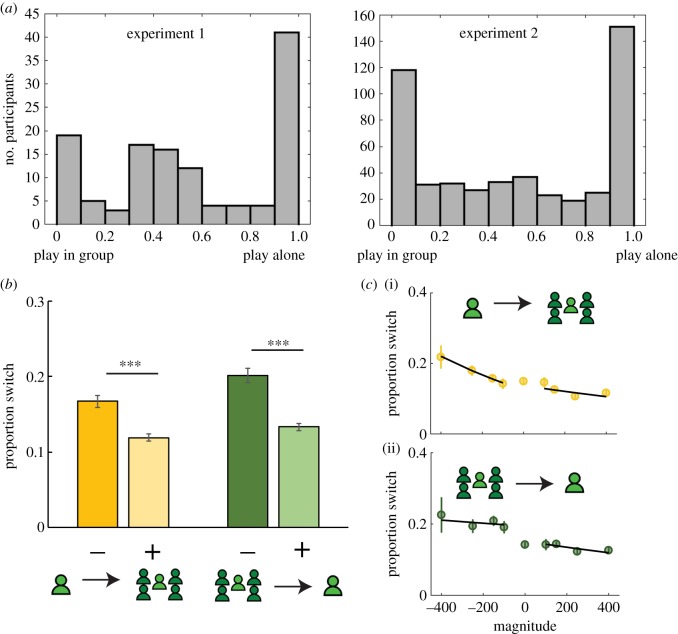
Group choice. (a) Histogram showing participants' overall tendency to play alone or in a group in experiment 1 (left panel) and experiment 2 (right panel). (b) In experiment 2, proportion of rounds where participants switched their choice to play alone or in group as a function of valence in the previous round: − negative outcomes, + positive outcomes, and of previous condition: outcomes experienced alone (yellow), outcomes experienced in group (green). (c) In experiment 2, proportion of rounds where participants switched their group choice as a function of outcome magnitude. (i) Outcome experienced alone. (ii) Outcome experienced in a group. Error bars represent standard errors of proportions. Statistics on the figure correspond to the reported outputs of the mixed models, ***p < 0.001. (Online version in colour.)